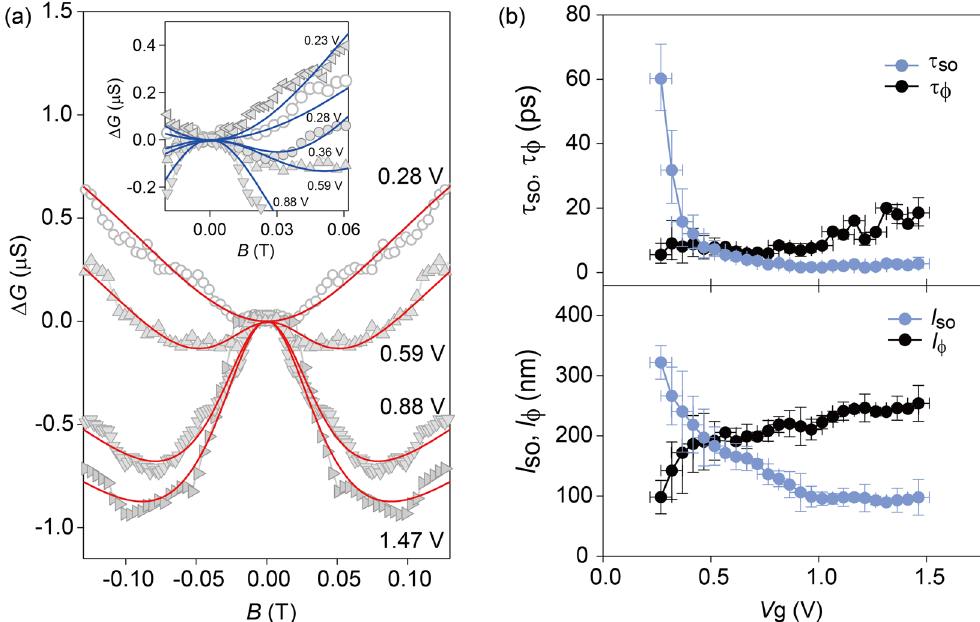
Figure 4. ( a ) Correction of conductance Δ G ≡ Δ G (B) − Δ G (0) as a function of magnetic field B for various gate voltages. The solid lines are fits using one-dimensional weak antilocalization model. The inset shows more data set near weak localization/weak antilocalization crossover. ( b ) V g dependence of spin-orbit relaxation length l so and phase coherence length l φ extracted from Δ G shown in ( a ) (bottom) and corresponding relaxation time τ so and τ φ vs. V g